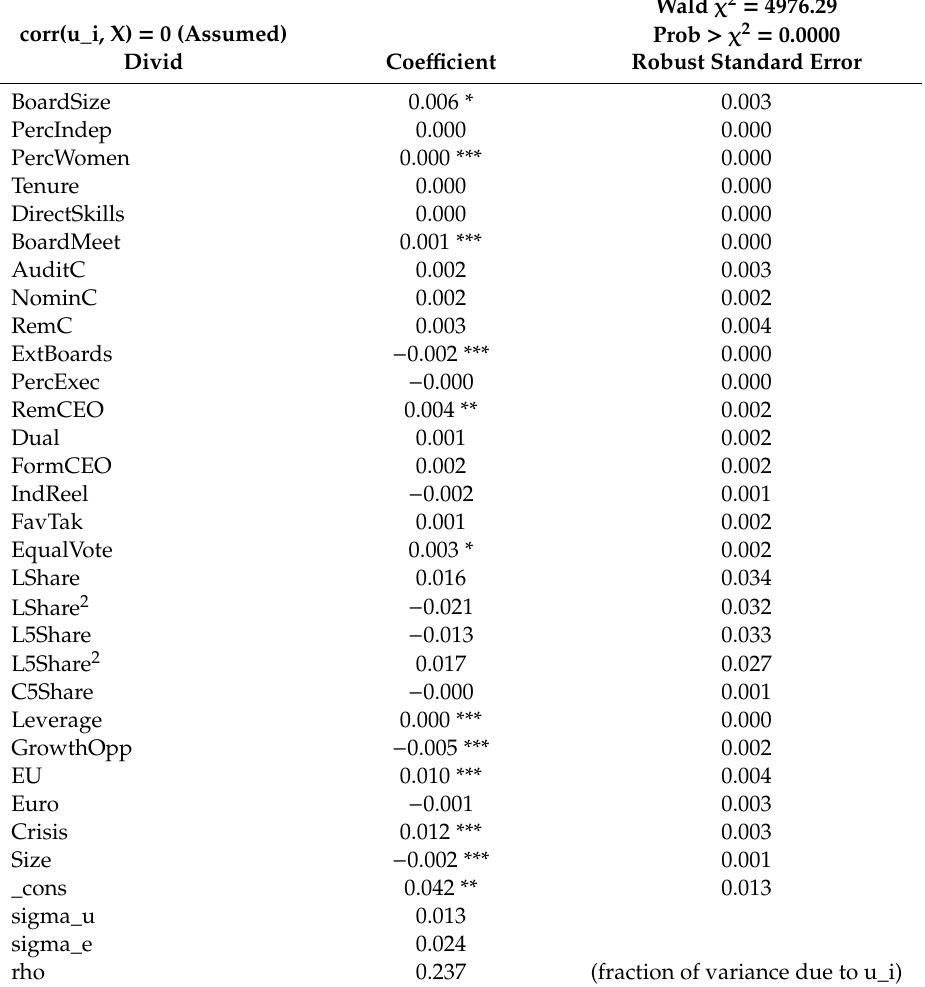
Table 4. The results of the regression based on a FGLS (feasible generalized least-squares) model for corporations paying dividends in each year. The independent variables are BoardSize, PercIndep, PercWomen, Tenure, DirectSkills, BoardMeet, AuditC, NominC, RemC, ExtBoards, PercExec, RemCEO, Dual, FormCEO, IndReel, FavTak, EqualVote, LShare, L5Share, C5Share, Leverage, GrowthOpp, EU, Euro, Crisis, Size, and Sector. The dependent variable was Divid. Sector dummy variables were included. The data covered the period from 2002 to 2013 and included the corporations established in the continental European countries that are listed and included in the Datastream’s Asset4 supplement. Data covered 2261 observations from 363